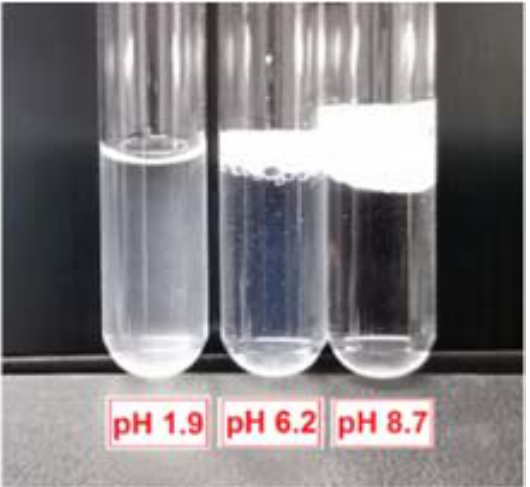
Figure 7. Turbid solution of R2 at pH = 1.9; clear solution of R2 at pH = 6.2 with some foam at liquid surface; clear transparent solution of R2 at pH = 8.7 with consistent formation of a foam at the liquid surface.